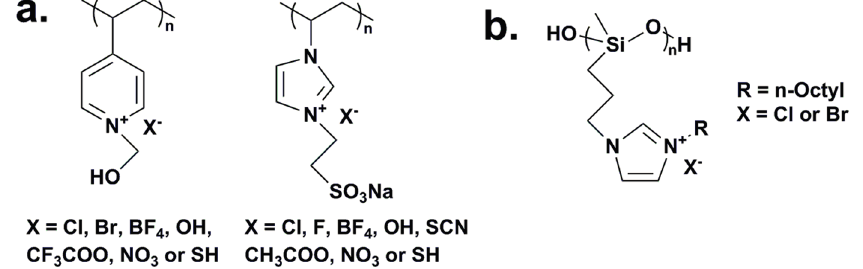
Figure 6. ( a ) Quaternary poly(4-vinyl-2-hydroxyethyl pyridinium) chloride and poly[1-vinyl-3-(2-sulfoethyl imidazolium betaine)] with various counter anions, adapted from [148,149]; ( b ) [ N -3( N '- n -octylimidazolio)propyl]methyl siloxane halide polymers, adapted with permission from